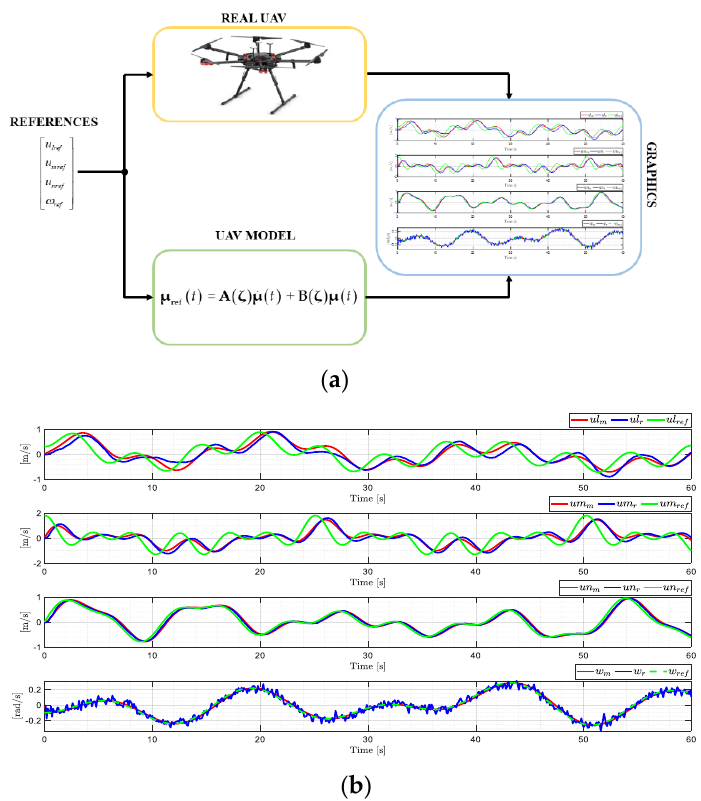
Figure 5. Velocities obtained from the dynamic model of the DJI Matrice 600 Pro, with the previ- ously identified dynamic parameters, closely resemble the real UAV velocities behavior during its experimentation. ( a ) Validation scheme; ( b ) Velocity signals comparison.